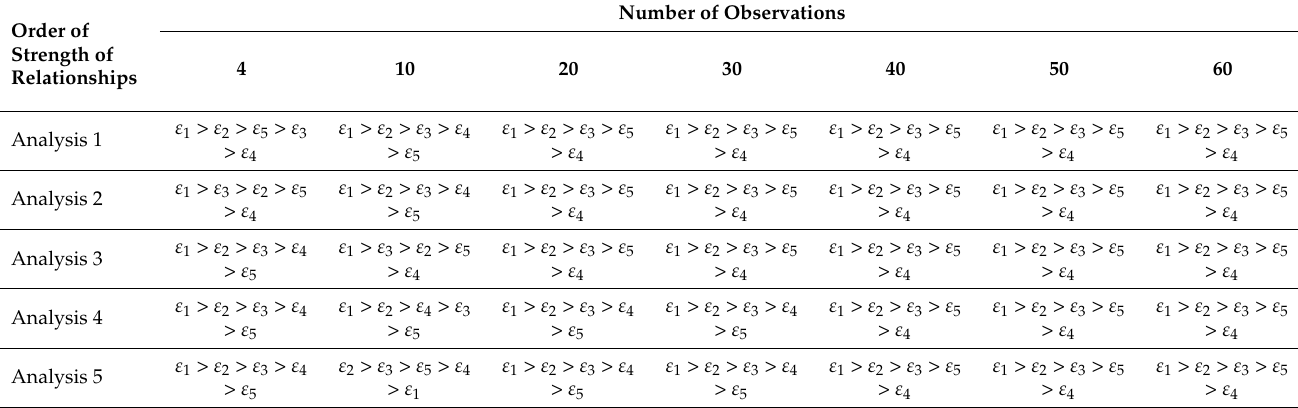
Table 4. The order of the ε similarity coefficient relationship depending on the number of observations included in the model at x i (1) equal to